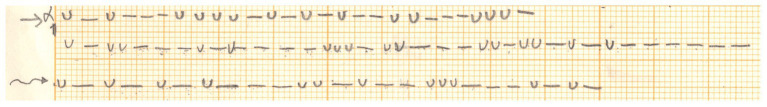
Metric feet in Xenakis’ sketches for Psappha, also printed in Barthel-Calvet (2000, p. 255 of the appendix). © Iannis Xenakis’ family. Reproduced by permission.